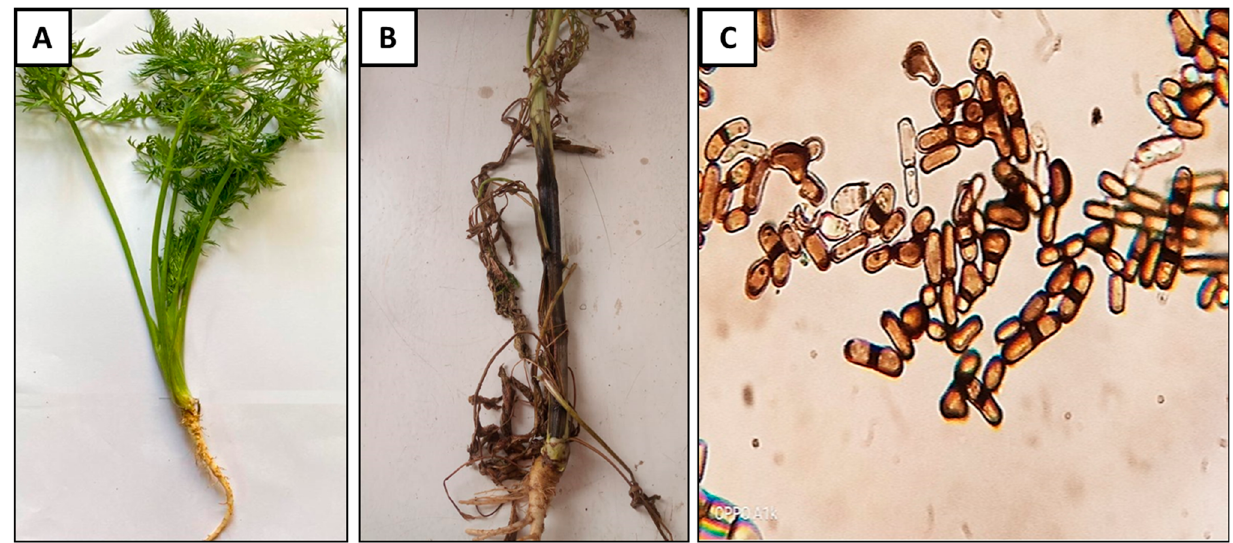
Figure 1. Healthy Carum carvi plant ( A ), Stem and foliar blight symptoms on Carum carvi plants ( B ), N. dimidiatum under light microscope (400×) ( C ). N. dimidiatum under light microscope (400 × ) ( C